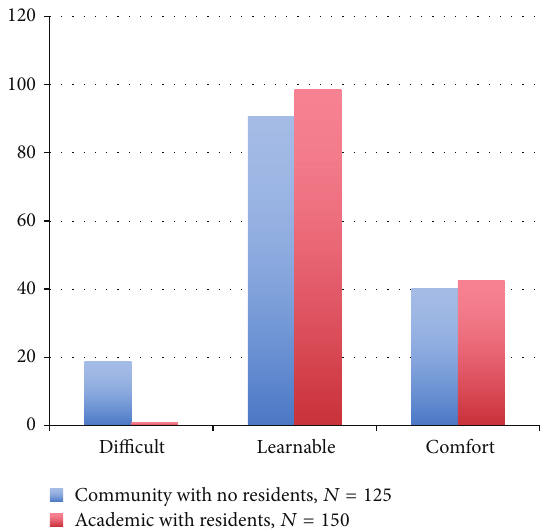
Figure 2: Percent agreement comparison of community surgeons without residents versus academic surgeons with residents.